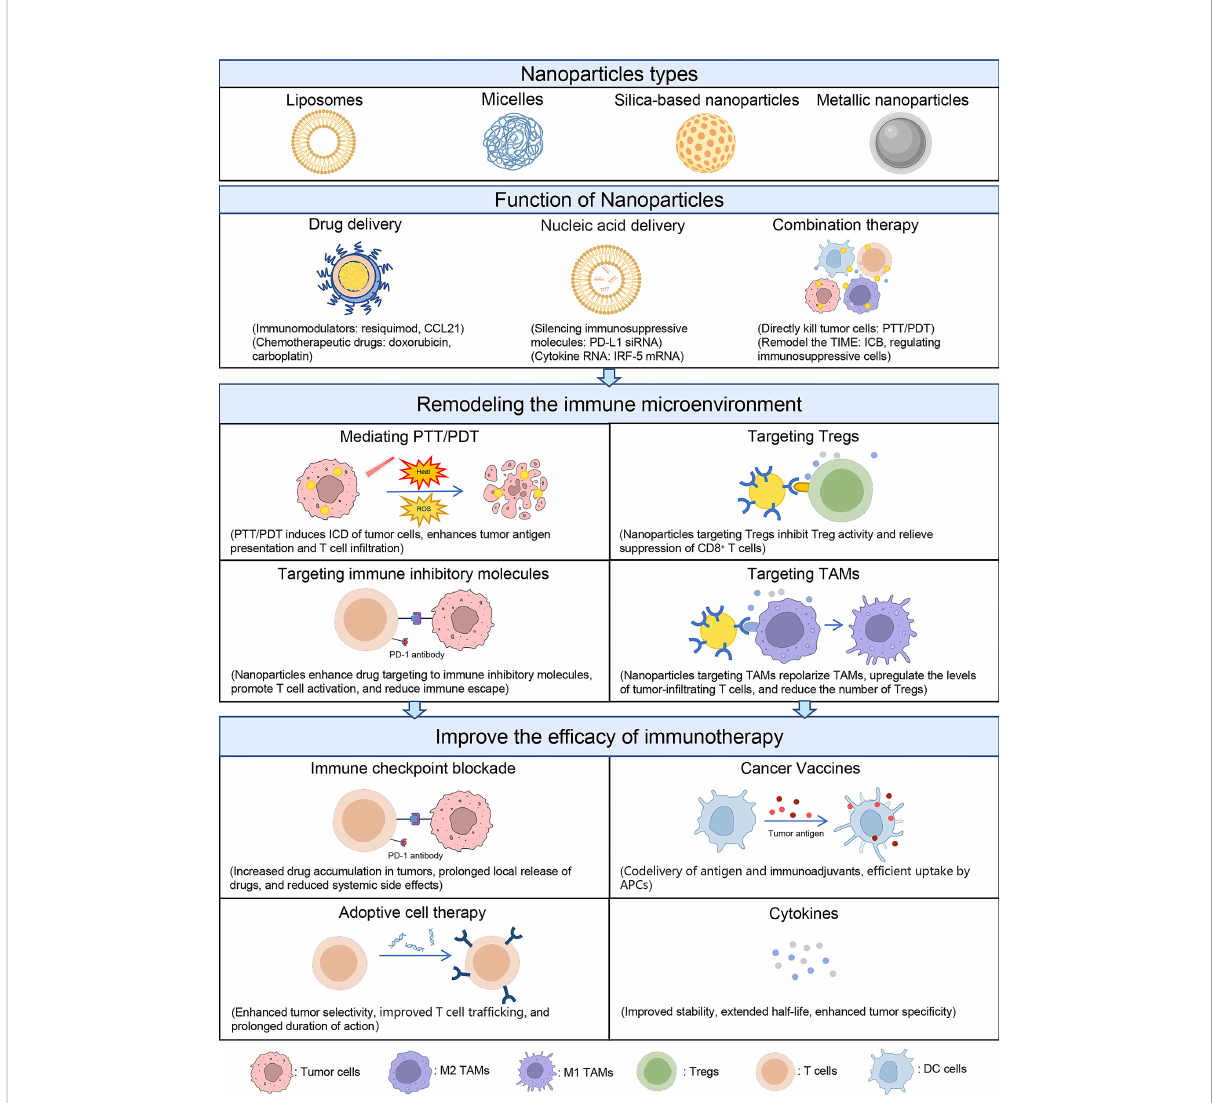
FIGURE 2 Schematic of nanoparticle-mediated immunotherapy regulating the TIME. Nanoparticles are mainly classi fi ed as liposomes, micelles, SNPs, and metallic nanoparticles. These nanoparticles have the functions of delivering drugs, delivering nucleic acids, and mediating combination therapy. Based on these functions, nanoparticles can regulate TIME in four ways: (1) mediating PTT and PDT to induce ICD in tumor cells; (2) improving drug targeting to immunosuppressive molecules; (3) targeting Tregs; and (4) targeting TAMs. By reversing the immunosuppressive state of TIME, nanoparticles can enhance the ef fi cacy of immunotherapy such as ICB, ACT, tumor vaccines, and